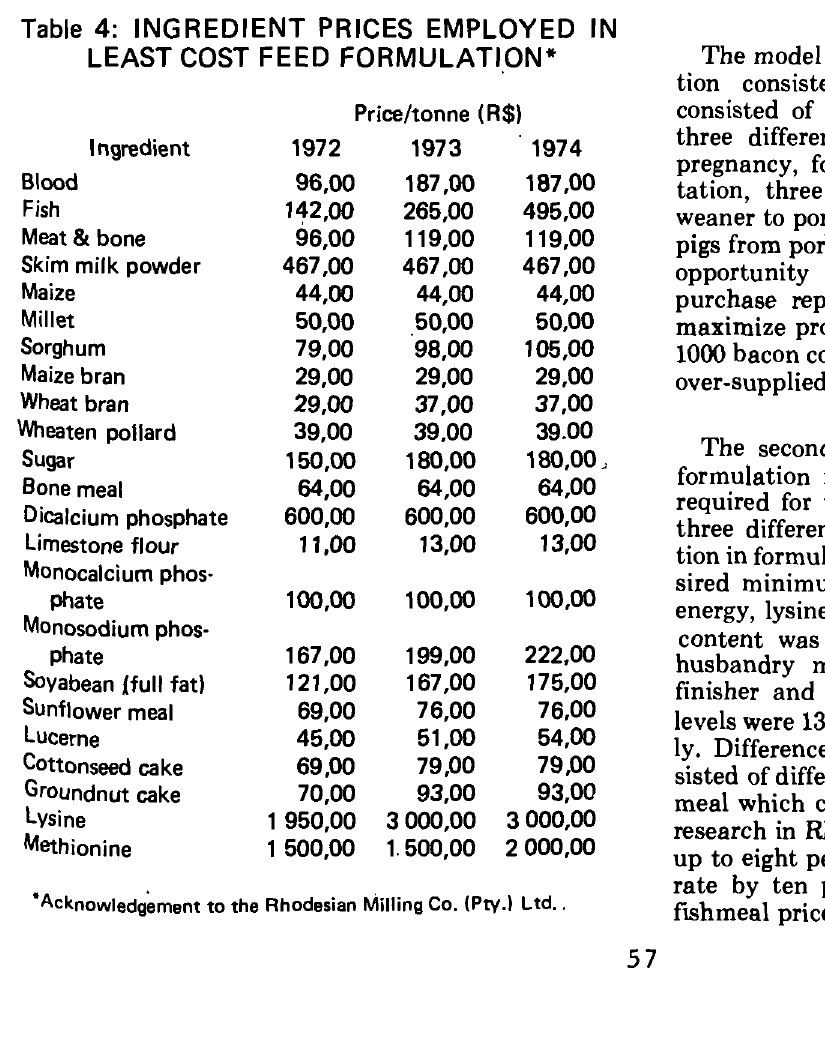
Table 4: INGREDIENT PRICES EMPLOYED IN LEAST COST FEED